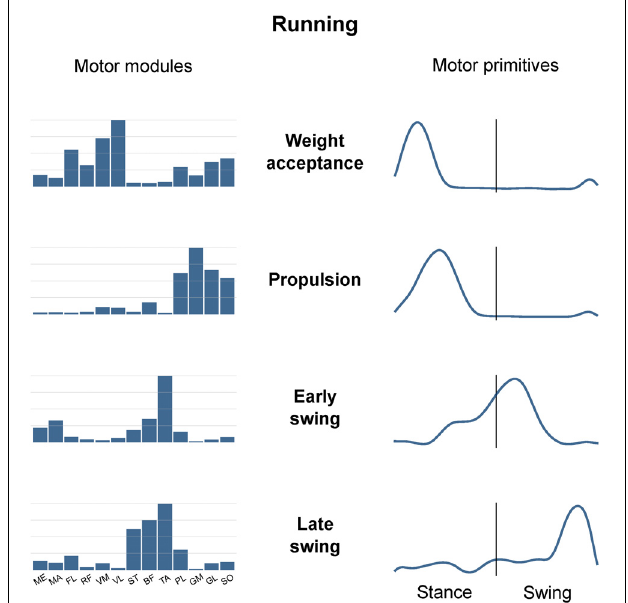
FIGURE 3 | Exemplary motor modules and motor primitives of the four fundamental synergies for human running (one trial). The motor modules are presented on a normalized y-axis base. For the motor primitives, the x-axis full scale represents the averaged gait cycle (with stance and swing normalized to the same amount of points and divided by a vertical line) and the y -axis the normalized amplitude. Muscle abbreviations: ME, gluteus medius; MA, gluteus maximus; FL, tensor fasciæ latæ; RF, rectus femoris; VM, vastus medialis; VL, vastus lateralis; ST, semitendinosus; BF, biceps femoris; TA, tibialis